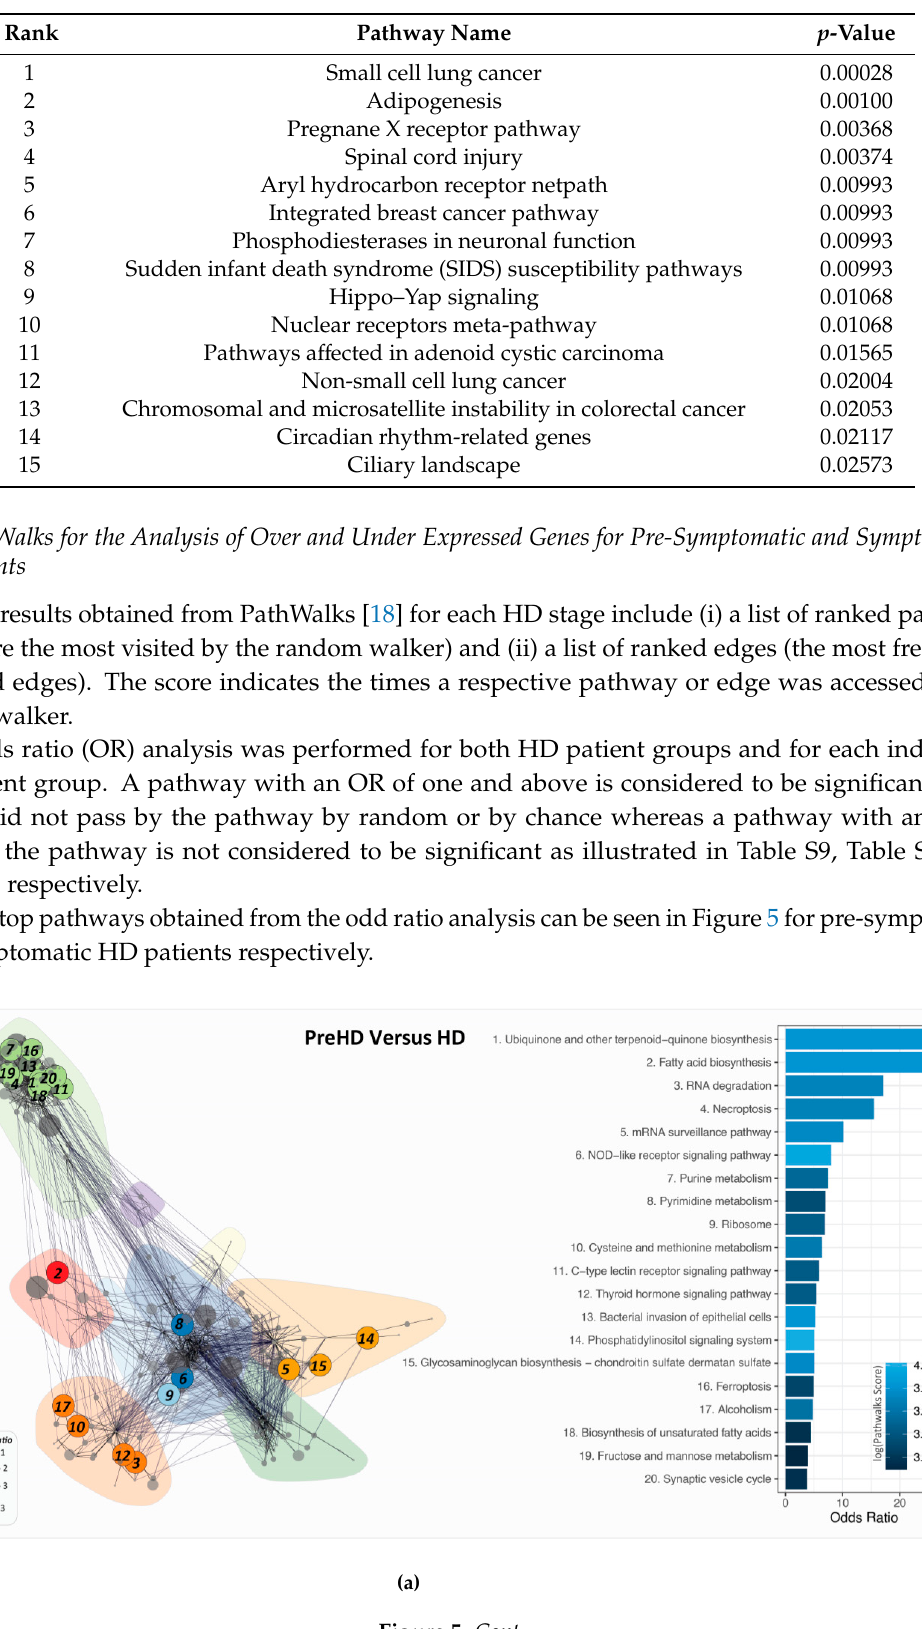
Table 2. The top-15 ranked pathways obtained from GeneTrial3 for symptomatic HD using